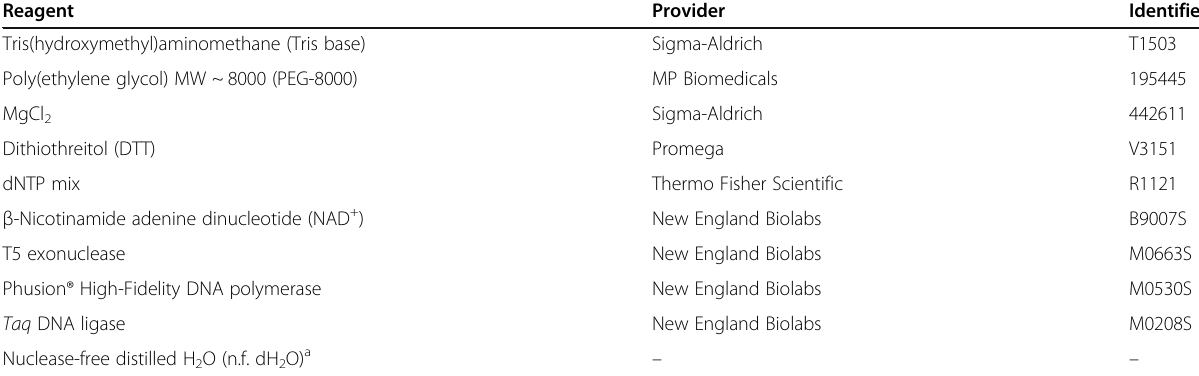
Table 1 Reagents for preparation of the home-made Gibson assembly (GA) enzymatic premix Reagent Tris(hydroxymethyl)aminomethane (Tris base)